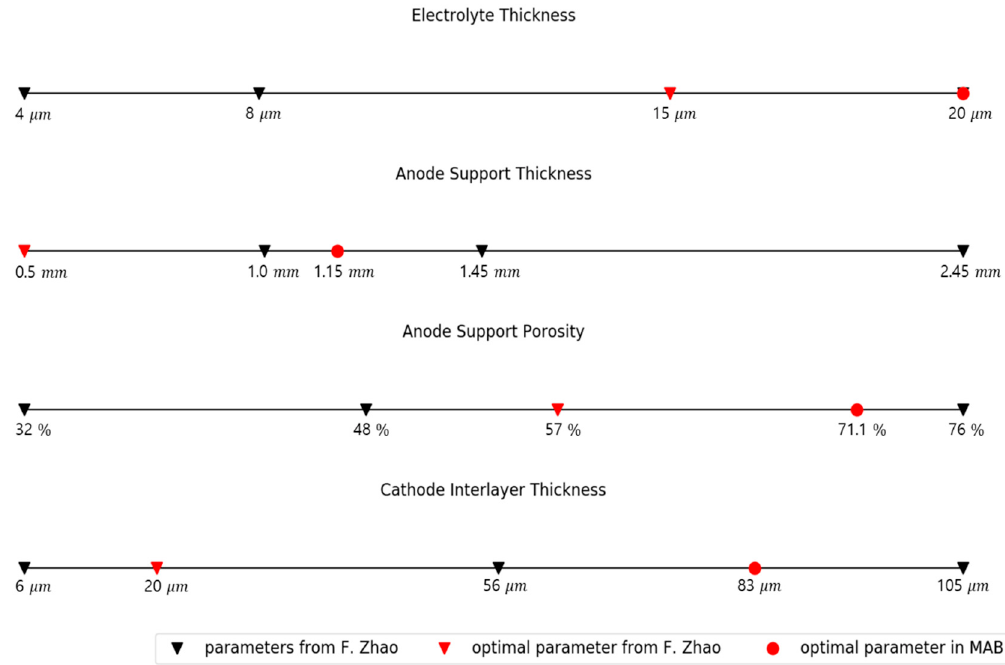
Figure 7. Comparison of the optimal parameters in our study and parameters in F. Zhao et al. study.